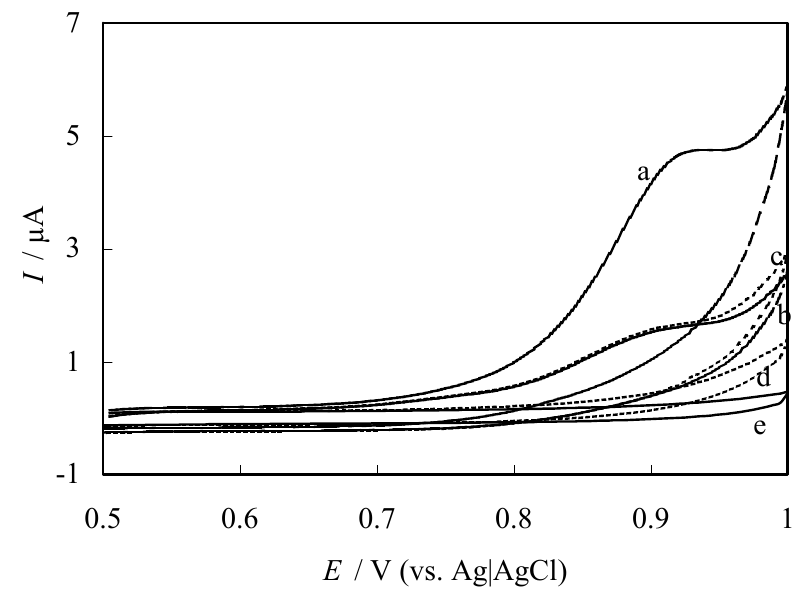
Figure 5. Cyclic voltammograms of FePyDP film modified ITO electrode in 50 mM PBS (pH 7.4) (a) with and (b) without 82.3 µ M NO, and (c) with 100 µ M NO 2- . Curves (d) and (e) are obtained in pure PBS at DNA-PADDA film with and without 82.3 µ M NO. Scan rate, 10 mV s -1